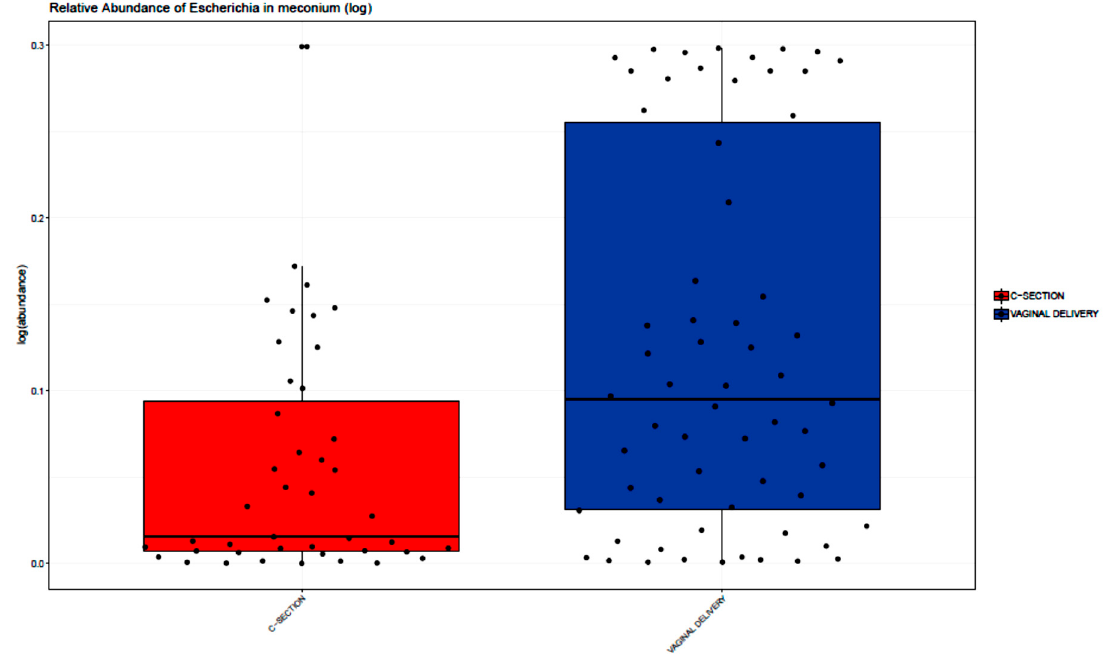
Figure 2. Relative abundance of Escherichia in meconium samples stratified by delivery mode. For each colored box: Horizontal bar = median, lower bar = first quartile (25th percentile), and upper bar = third quartile (75th percentile). Escherichia was higher in meconium samples from infants born by VD (38%) compared with CS (15%), FDR adjusted p < 0.001.